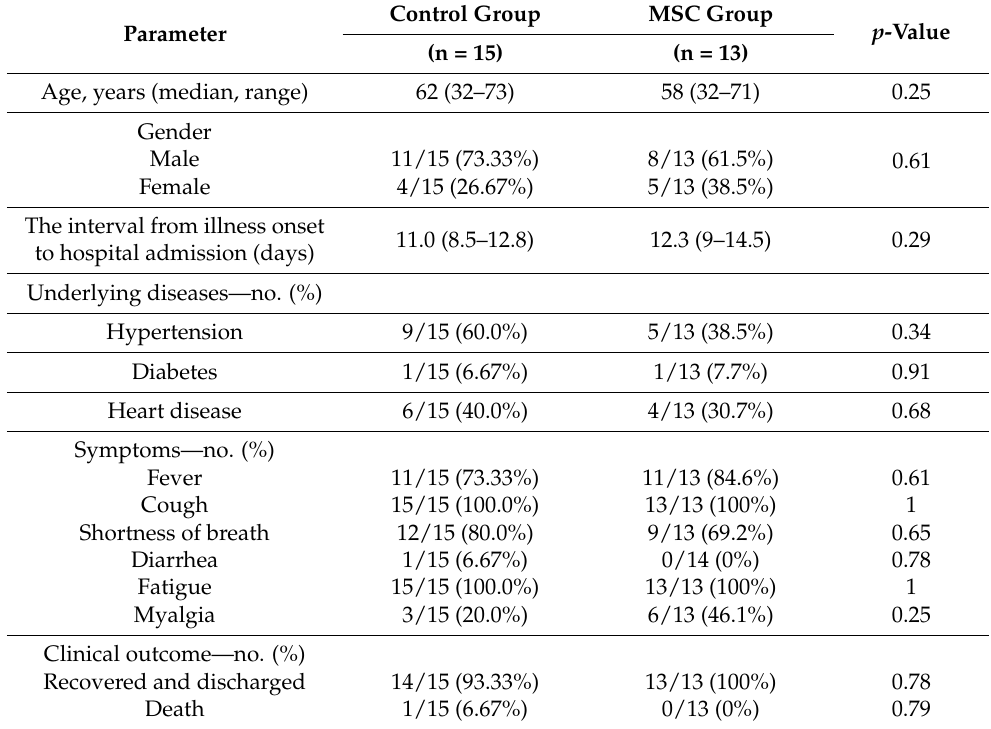
Table 1. Clinical characteristics of patients with COVID-19 included in this